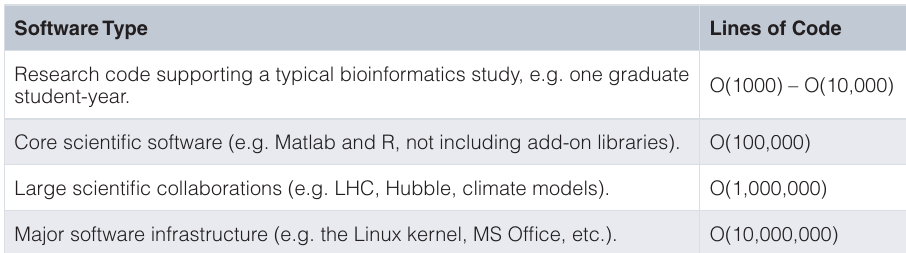
Table 1. Number of lines of code in typical classes of computer programs (via